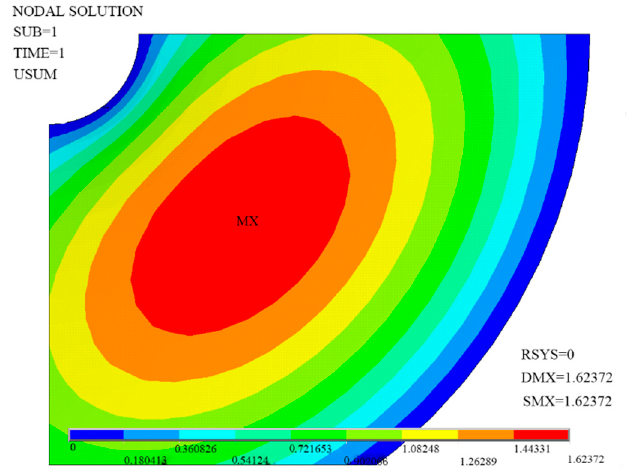
Figure 6. The schematic diagram of boundary condition loading and film deformation.